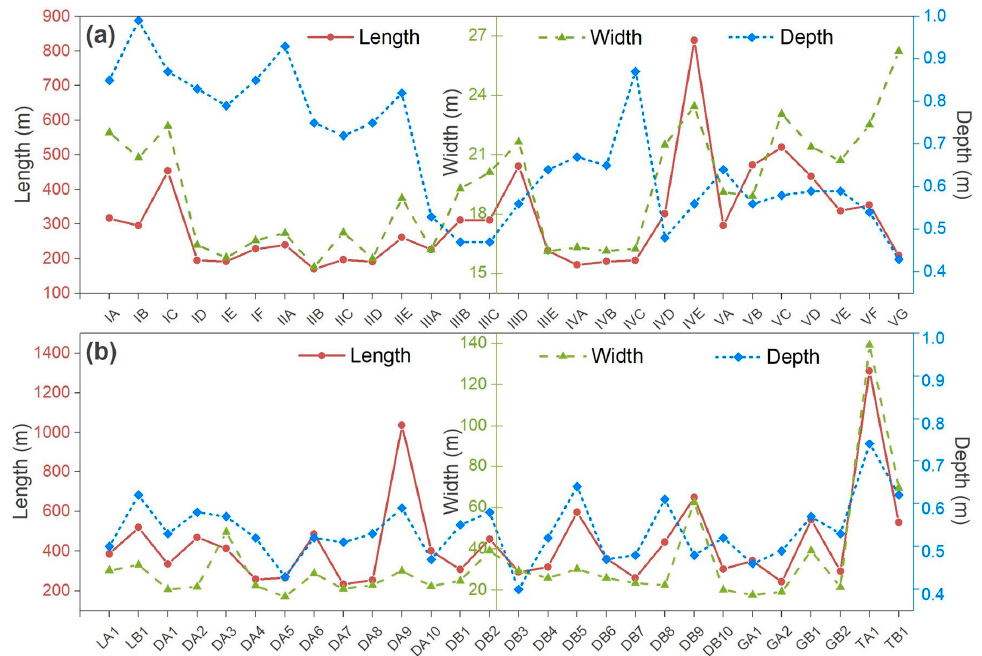
Figure 13. Mean length, width, and depth of the 56 tidal basins. ( a , b ) are coastal and offshore, respectively.